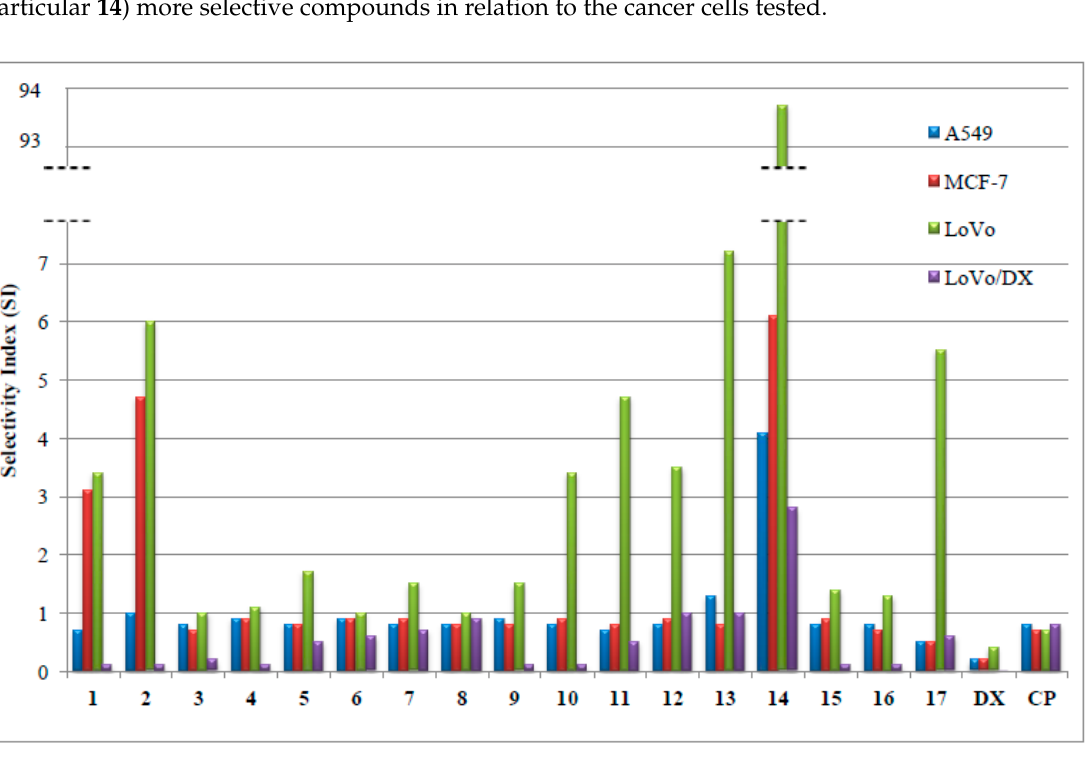
Figure 1. Comparison of selectivity index (SI) values of the tested compounds. The SI (Selectivity Index) was calculated for each compound using the formula: SI = (IC 50 for normal cell line BALB/3T3)/(IC 50 for respective cancerous cell line). A favorable SI > 1.0 indicates a drug with efficacy against tumor cells greater than the toxicity against normal cells.